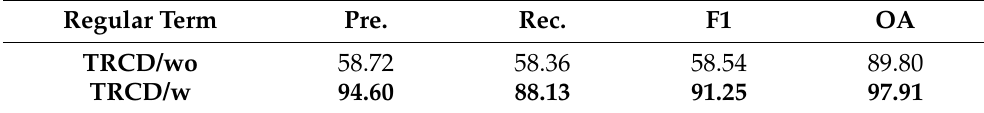
Table 7. Quantitative results of proposed objective function on CDD with 6000 pairs of images. Regular Term Pre.